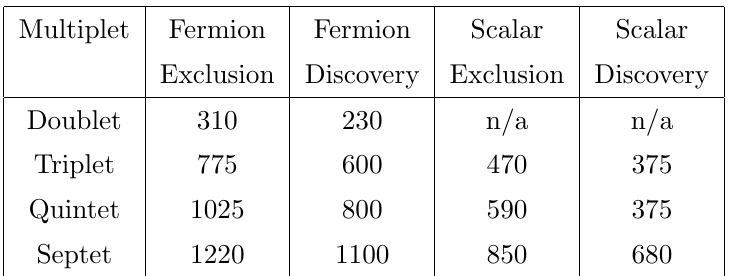
Table 3 . Prospective exclusions and discovery reach in GeV from direct searches at CLIC when the mass splitting is purely radiative. For the scalar and fermion triplet, these limits derive from disappearing track searches; for the remaining models, they are set by